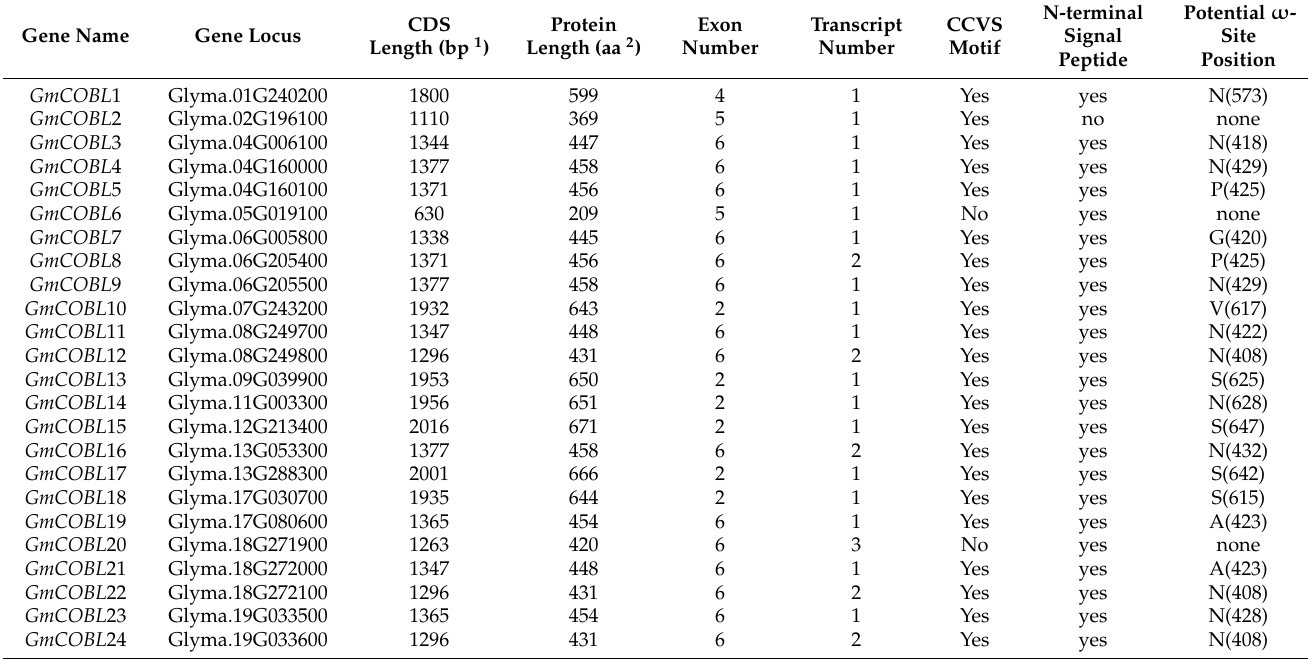
Table 1. Summary of COBRA-like ( COBLs ) gene family members identified in